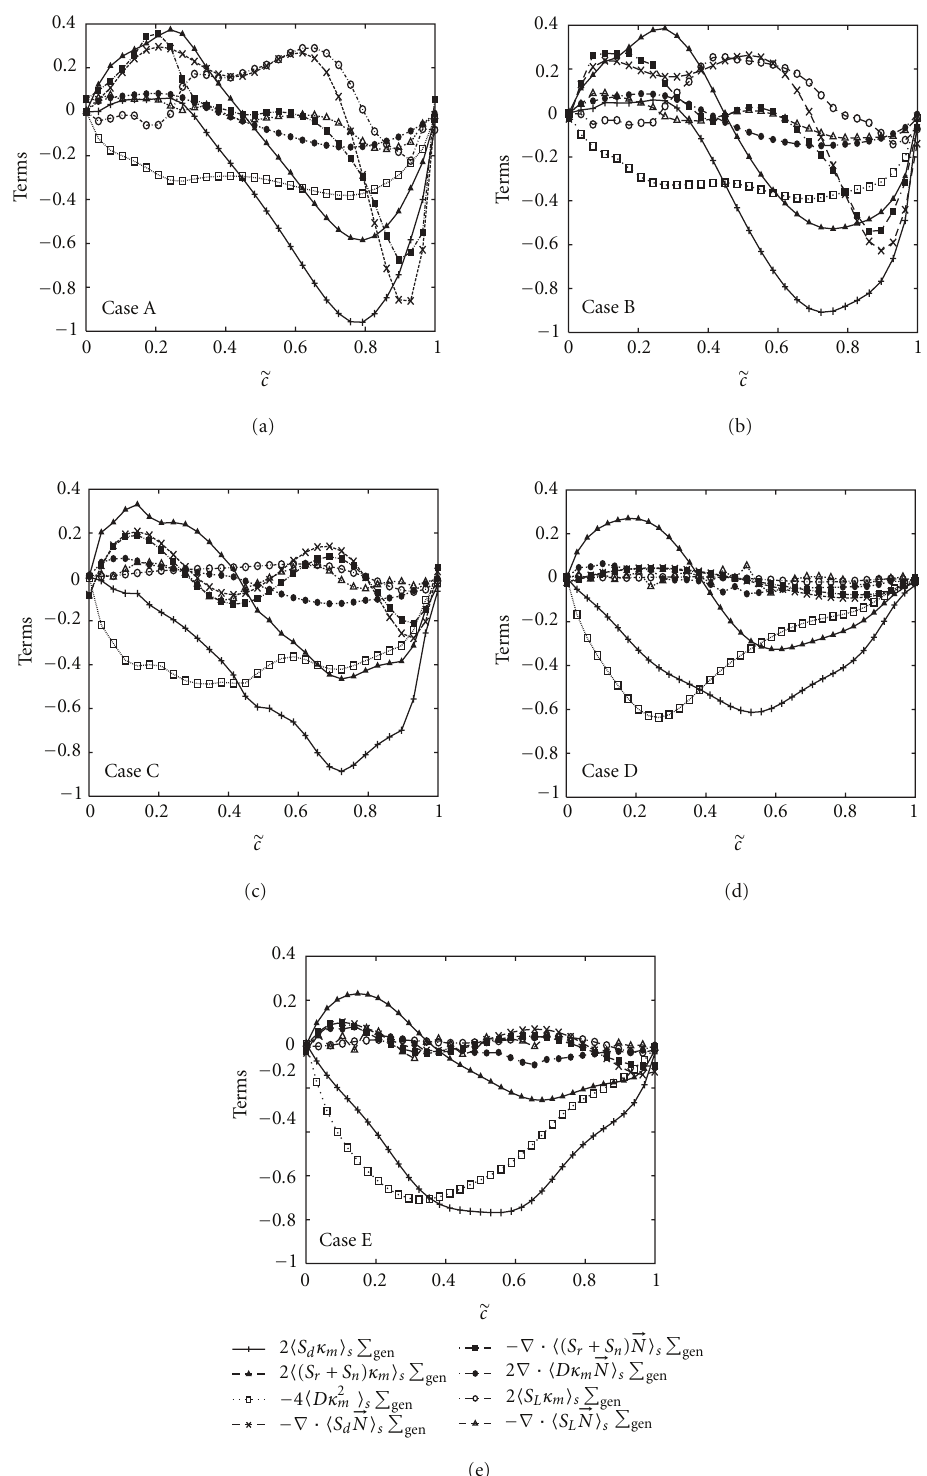
Figure 12: Variation across the flame brush with Favre averaged reaction progress variable (cid:21) c = (cid:9) ρc (cid:10) / (cid:9) ρ (cid:10) of the FSD curvature term 2 (cid:9) S d κ m (cid:10) s Σ gen and its contributions (see (12c)) 2 (cid:9) ( S r + S n ) κ m (cid:10) s Σ gen and − 4 (cid:9) Dκ 2 m (cid:10) s Σ gen ; the FSD propagation term −∇ · (cid:9) S d its contributions (see (12d)) −∇ · (cid:9) ( S r + S n ) propagation term −∇ · (cid:9) S L /δ 2 S of the respective L th